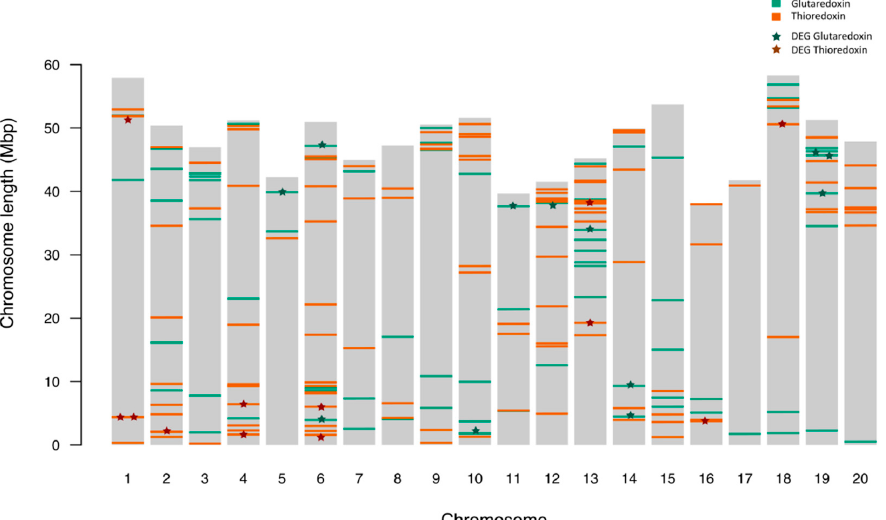
Figure 1. Distribution of the 125 GmTrx and 89 GmGrx gene family members on Glycine max chromosomes. The color of each gene indicates the corresponding family. Asterisks indicate the differentially expressed GmTrx and GmGrx genes.